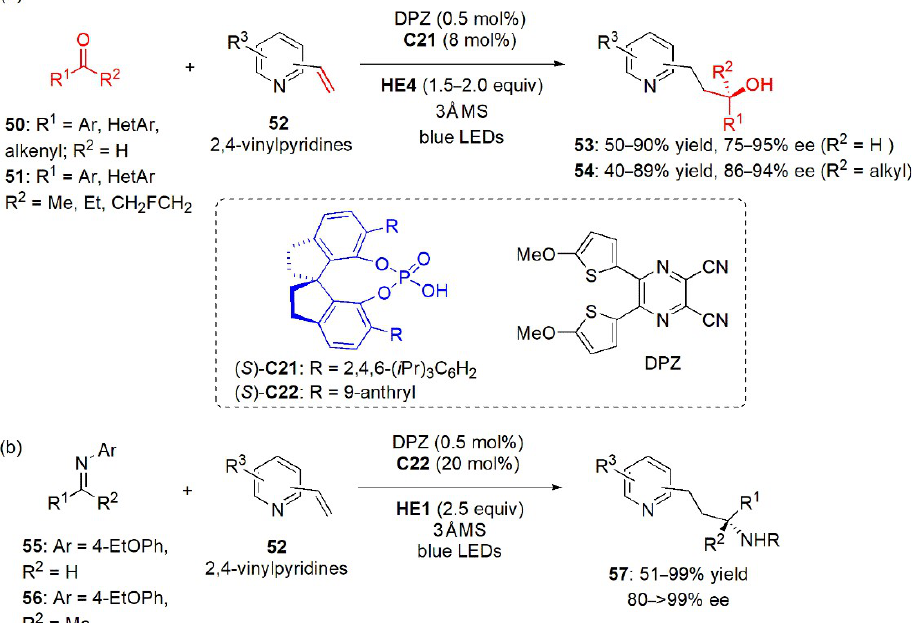
Figure 18. ( a , b ) Catalytic enantioselective addition of prochiral radicals to vinylpyridines under photoredox conditions and CPA catalysis [87]. photoredox conditions and CPA catalysis